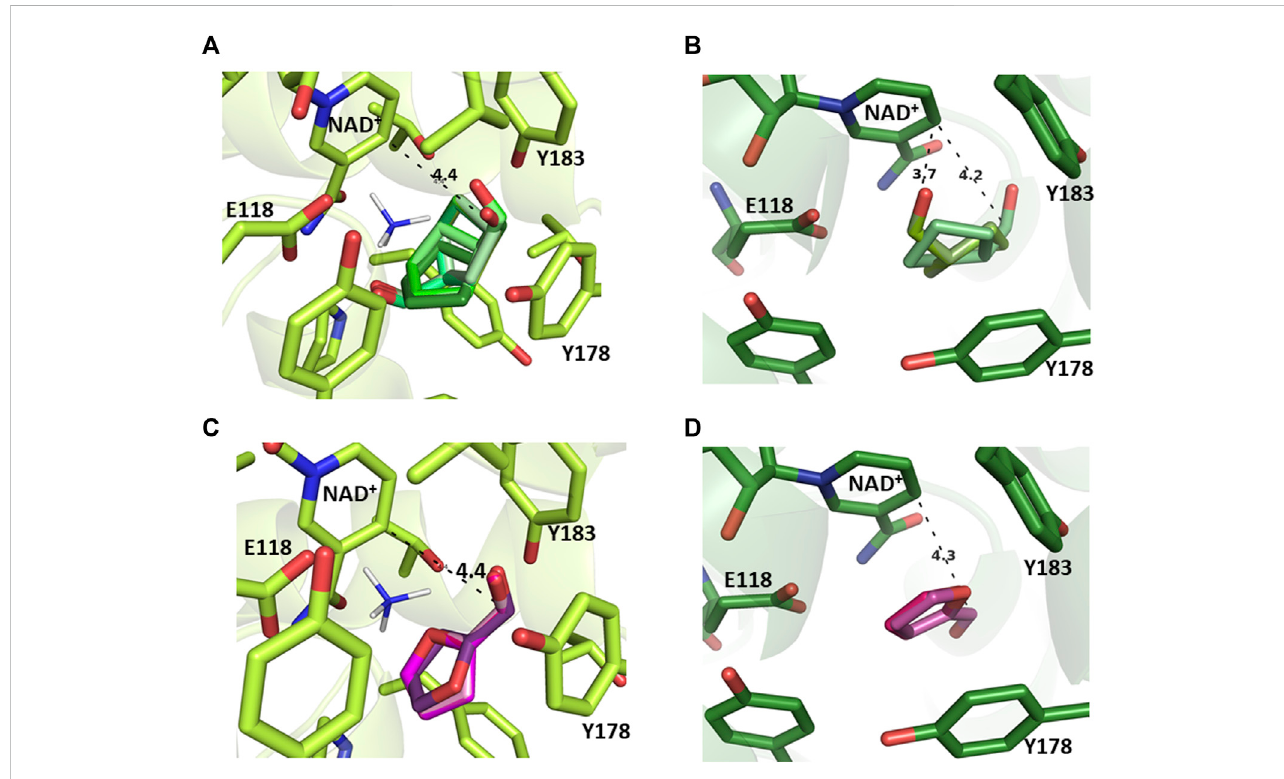
FIGURE 5 Active sites of Rgna AmDH docked (A) with NH 4 + and 7a; (B) without NH 3 and 7a; (C) with NH 4 + and 6a; (D) without NH 3 and 6a. Distances are in Å. For clarity, only one conformation is shown in the case of several almost identical